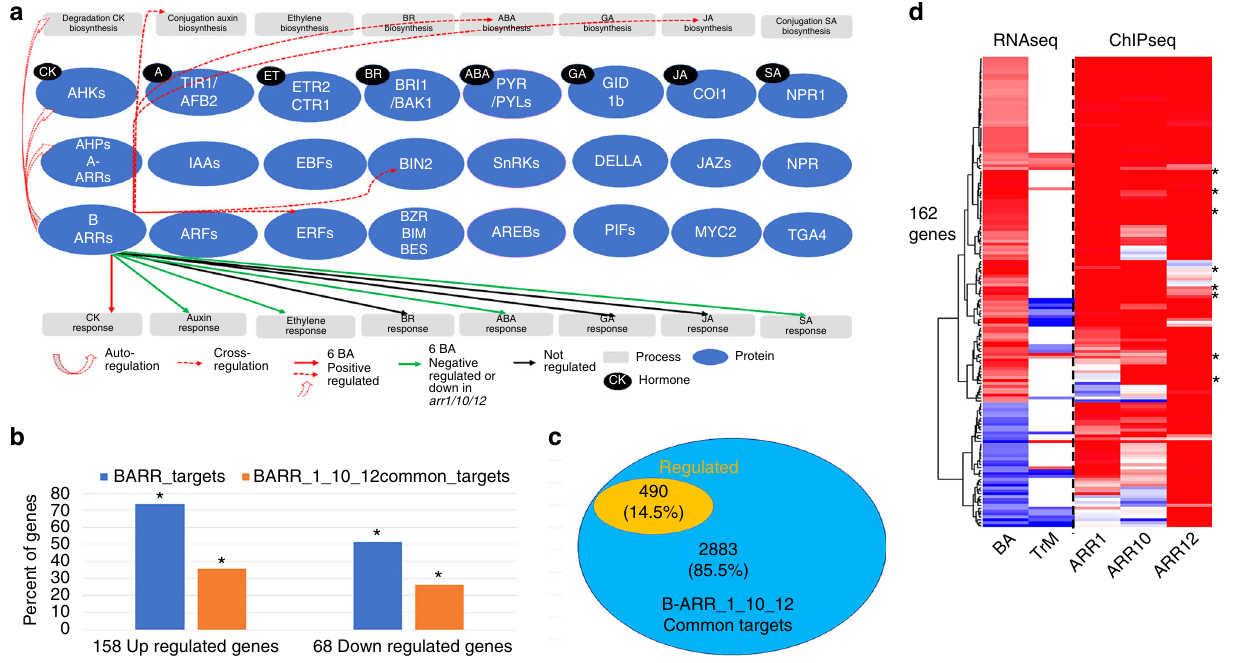
Fig. 4 Enriched GO categories for B-ARRs target genes. a Interaction graph drawn from GO categories of nearby target genes of B-ARRs. The model shows that B-ARRs regulate every step of both cytokinin biosynthesis and signaling pathways and cross-regulate other plant hormone pathways. Hormone annotation legend: CK cytokinin, A auxin, ET ethylene, BR brassinosteroid, ABA abscisic acid, GA gibberellin, JA methyl jasmonate acid, SA salicylic acid. Red arrow: genes with increased transcript levels after cytokinin treatment; Green arrow: genes with decreased transcript levels in arr1/10/12 triple mutants compared to wild type or genes repressed by cytokinin. Black arrow: genes with regulated (for BR) and not-regulated (for GA and JA) transcript levels in arr1/10/12 triple mutants compared to wild type. b Comparison between B-ARR targets and cytokinin response genes in the golden list 20 using Fisher ’ s exact test (asterisk (*) indicates corrected p < 0.05). c The subset of B-ARR 1, 10, and 12 candidate target genes also showing transcript changes (regulated). d A heatmap shows both cytokinin regulation and B-ARR binding for a subset of 162 common targets of B-ARR 1, 10, and 12. A-ARRs were highlighted (*). Z scores for RNA-seq were based on log2 fold changes (6-BA treatment compared to mock and triple mutants compared to wild type) and for DNA binding were based on log2 peak score ( − log2( p -value)). RNA-seq was acquired from 4-h 6-BA treatment (BA) or in arr1/10/12 triple mutants (TrM). DNA-binding for 6-BA treatment target genes of B-ARR-1 (ARR1), B-ARR-10 (ARR10), and B-ARR-12